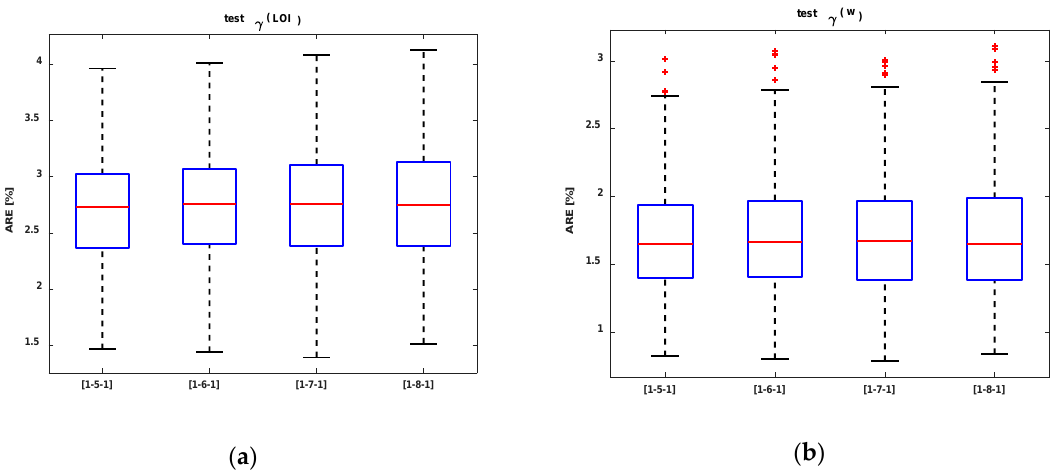
Figure 14. Comparison of the MRE of the nets with one element in the input vector: ( a ) LOI T and ( b ) w . Table 6. The goodness of fit of the ANN models with two inputs.